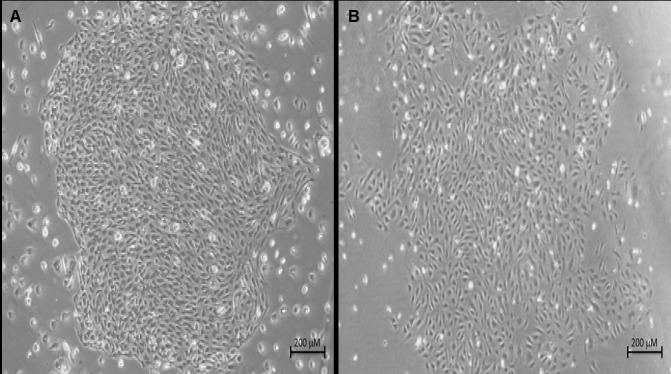
Identification of ECFCs obtained from peripheral blood from controls and patients with VTD.Representative photomicrograph (40X magnification) of colonies formed by ECFCs in cultures of MNCs obtained from peripheral blood after 14 days in culture. (A) controls and (B) patients with history of VTD.